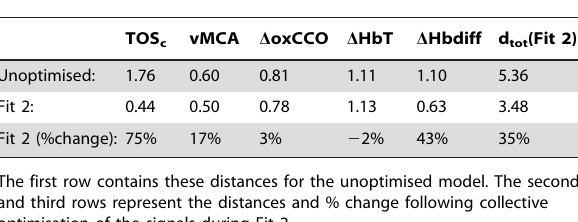
Table 4. The (weighted) signal-to-data distances for each of the five measured signals, and the sum of these distances, averaged across all thirty challenges for Fit 2.